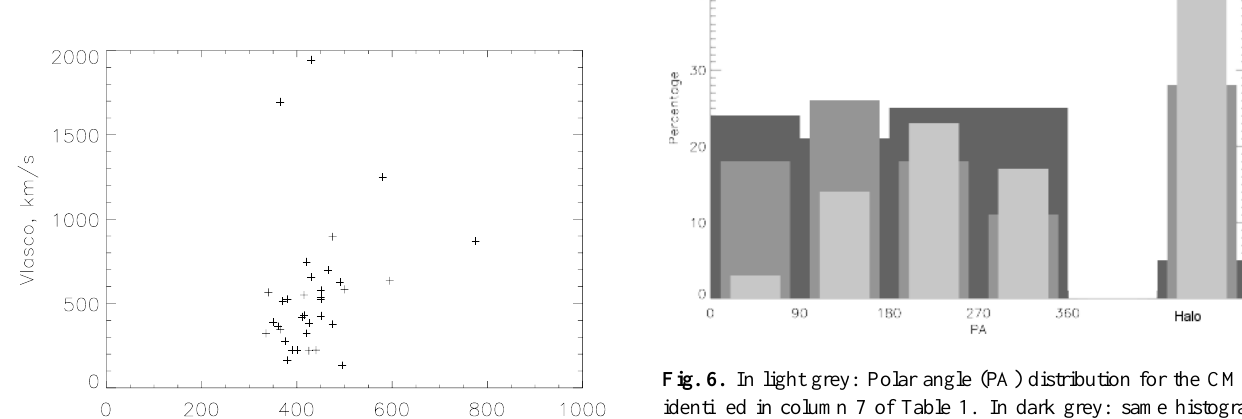
Fig. 3. In light grey: Histogram of 1T (difference between the onset time of the chosen CME (column 7, Table 1) and t c (column 5)) for all the cases of Table 1. In black: same histogram for cases when the chosen CME (column 7) is different from the CME in column 6 of Table 1. In dark grey: same histogram for the CMEs of column 6 closest to t c .